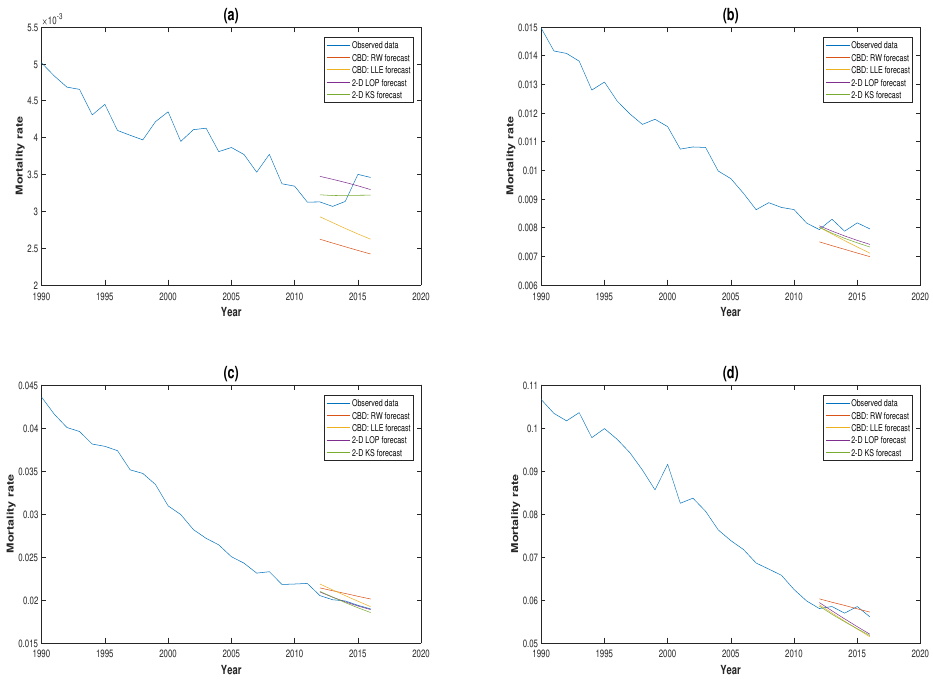
Figure 3. Five-year-ahead forecast from 2012–2016 for GB males aged ( a ) 50, ( b ) 60, ( c ) 70 and ( d ) 80 based on mortality data since 1950.